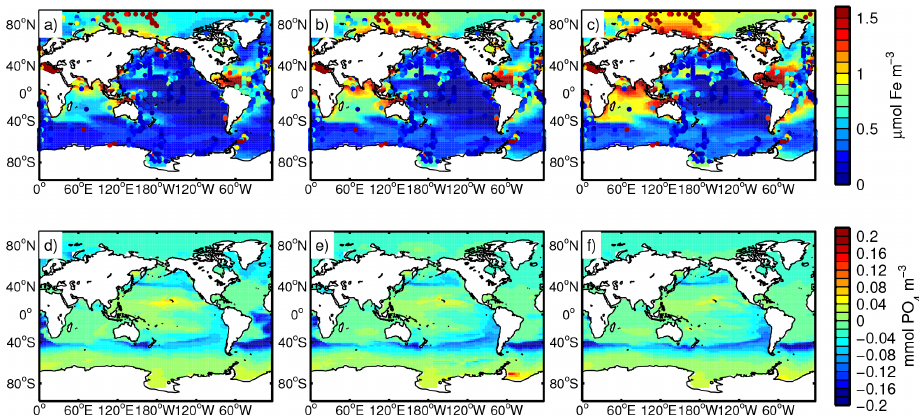
Figure 18. Impact of setting the iron solubility in dust to a constant value of 1%. Annual mean simulated surface iron concentrations with observations compiled by Tagliabue et al. (2012) averaged over the first 50m plotted as colored circles on top for experiment SOL08 are shown in (a) , for SOL10 in (b) and for SOL12 in (c) . The difference between the annual mean surface phosphate concentrations after 1000 years of experiment SOL08 and LIG08 are shown in (d) , between SOL10 and LIG10 in (e) and between SOL12 and LIG12 in (f) . The experiments are listed in Table